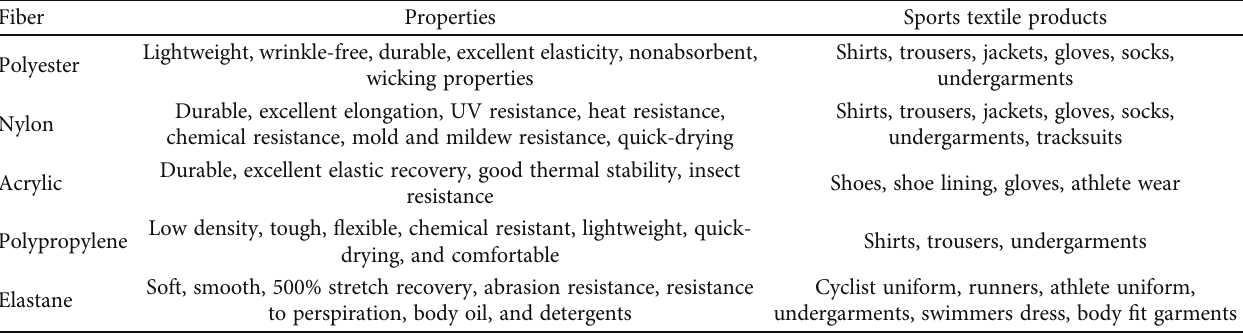
Table 3: Synthetic fi bers properties and their applications in sports textile products.